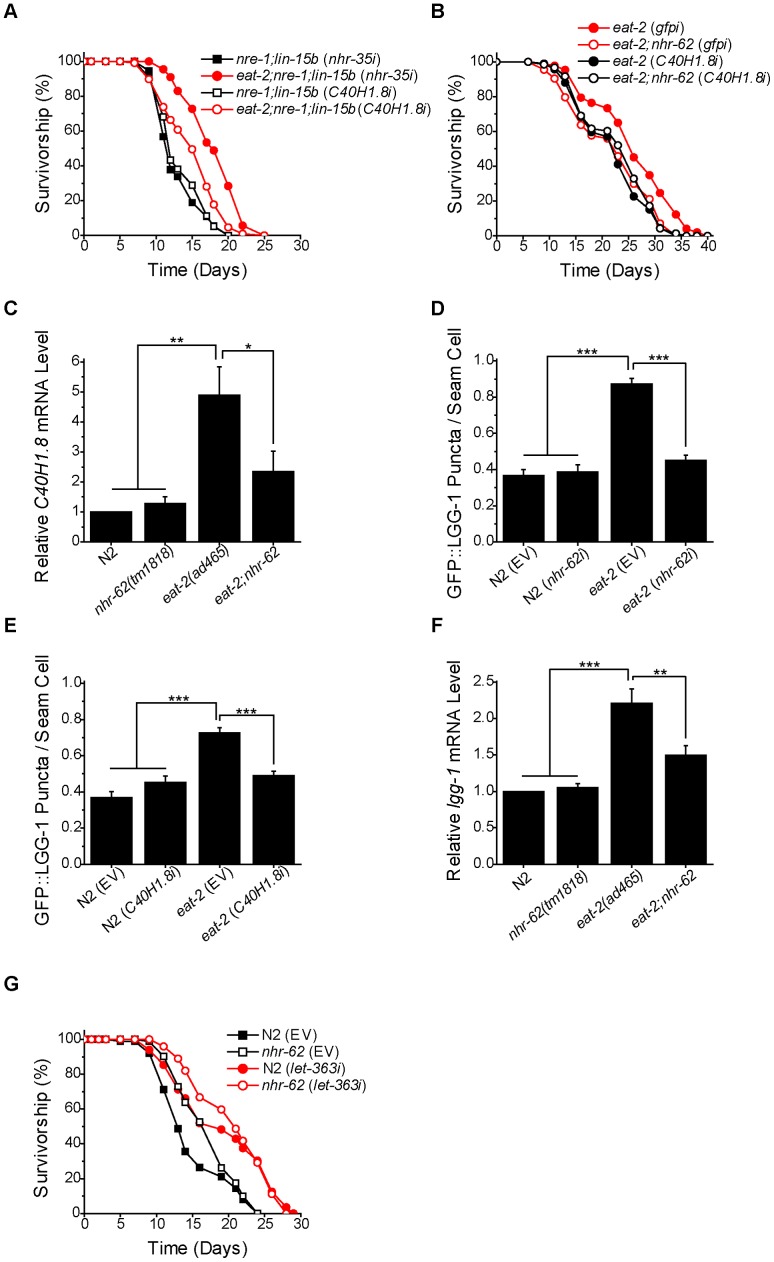

nhr-62 regulates a DR-induced lipase and autophagy.(A) eat-2;nre-1;lin-15b worms fed C40H1.8 RNAi had a significantly reduced lifespan compared to eat-2;nre-1;lin-15b worms fed nhr-35 control RNAi (log-rank test p<0.001). See Figure S5 for additional experiments. (B) C40H1.8 RNAi did not decrease the lifespan of eat-2;nhr-62 worms compared to eat-2;nhr-62 (gfpi). (log-rank test p = 0.4798). (C) The up-regulation of C40H1.8 expression under DR was significantly suppressed in eat-2;nhr-62. (D) The induction of GFP::LGG-1 puncta formation in eat-2(ad465) was significantly suppressed to ad libitum levels by nhr-62 RNAi (combined data from 3 independent experiments). (E) The induction of GFP::LGG-1 puncta formation in eat-2(ad465) was significantly suppressed to ad libitum levels on C40H1.8 RNAi (combined data from 3 independent experiments). (F) The up-regulation of lgg-1 expression under DR was significantly suppressed in eat-2;nhr-62. (G) Both wild-type (N2) and nhr-62(tm1818) worms fed let-363/TOR RNAi had a significant increase in lifespan when compared to controls (log-rank test p<0.001). EV = empty vector . *p<0.05, **p<0.01, ***p<0.001 by single factor ANOVA with Tukey test. Mean±SEM.